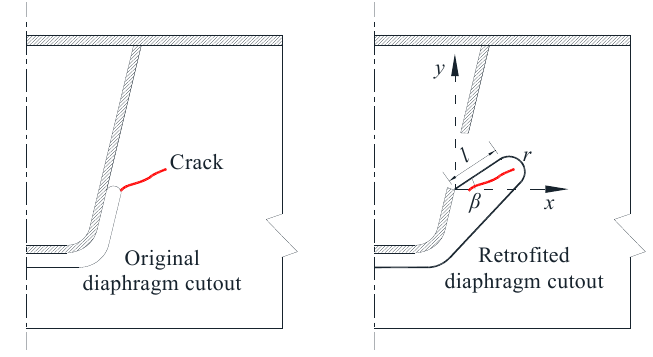
Figure 10. Shape parameters of a diaphragm cutout.